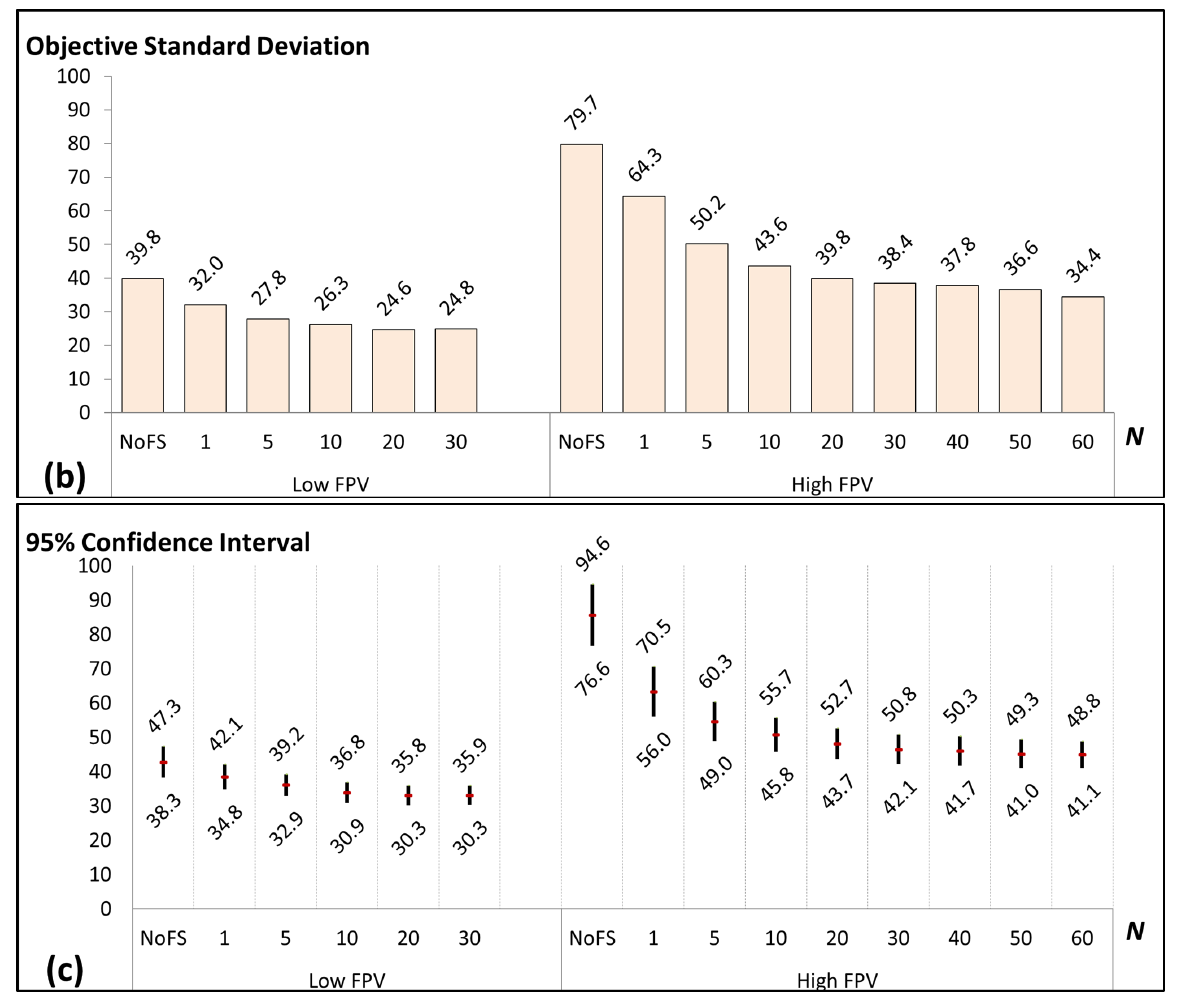
Figure 7. The overall performance of FT1s generated by the stochastic program using different sample sizes N: ( a ) objective function value means; ( b ) objective function standard deviations; ( c ) 95% confidence intervals of the objective function value means.